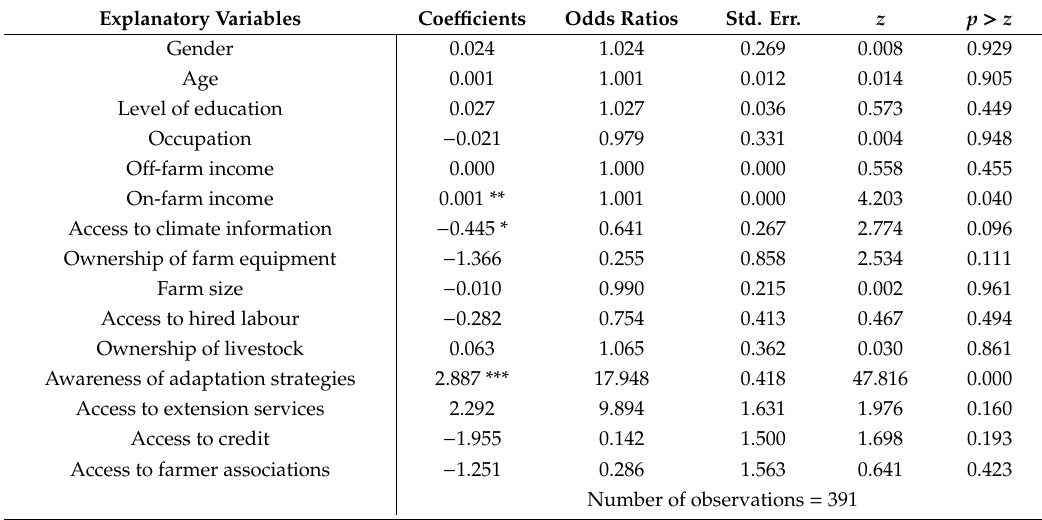
Table 6. Estimated results on the factors determining the adoption of traditional adaptation